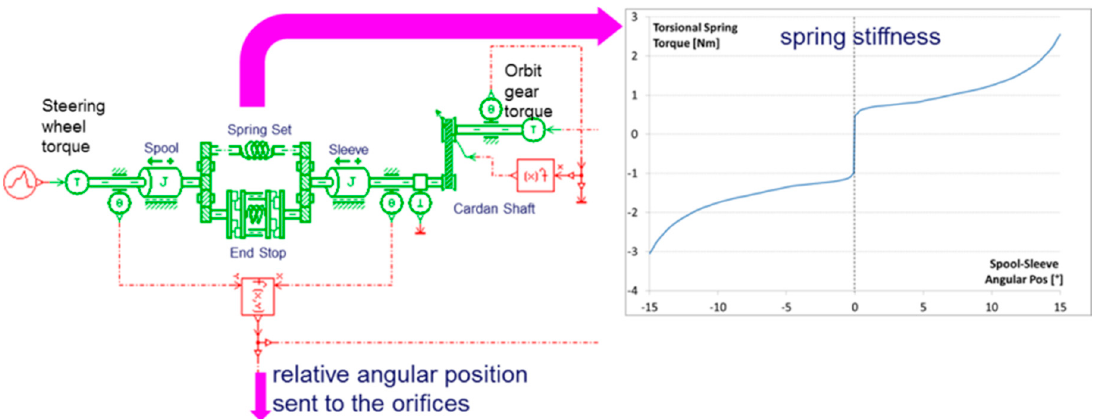
Figure 5. Model of the two interconnected rotary inertias of the spool and the sleeve.